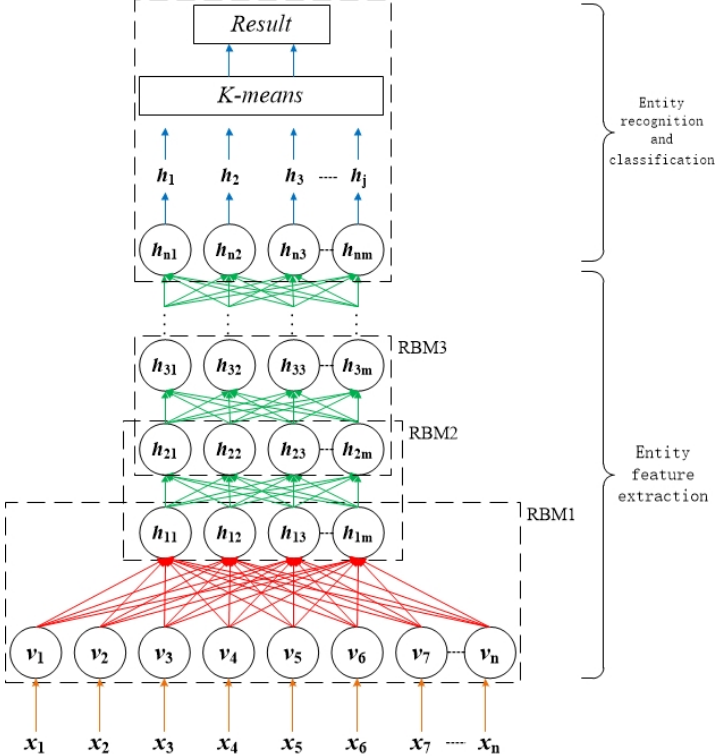
Figure 3. Entity recognition